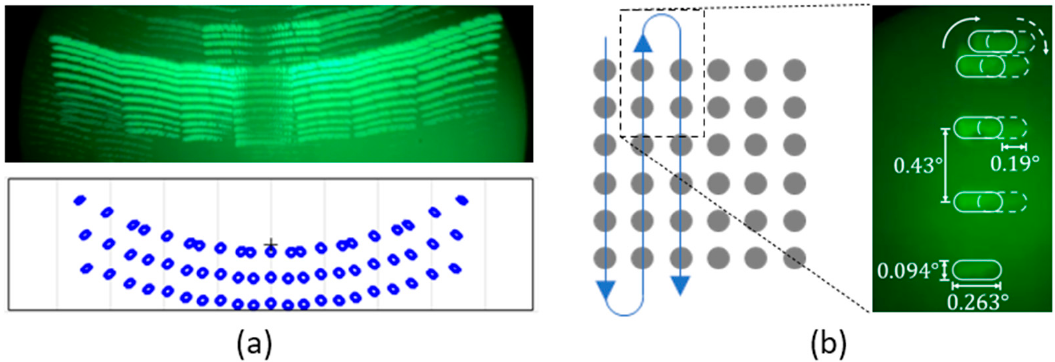
Figure 7. ( a ) A long exposure of the scanning pattern captured by an IR viewer (top), and simulated scanning pattern (bottom). ( b ) Beam scanning pattern at the top edge of the sub-FOV with beam divergence values. The “+” indicates the center of 0 th order sub-FOV.